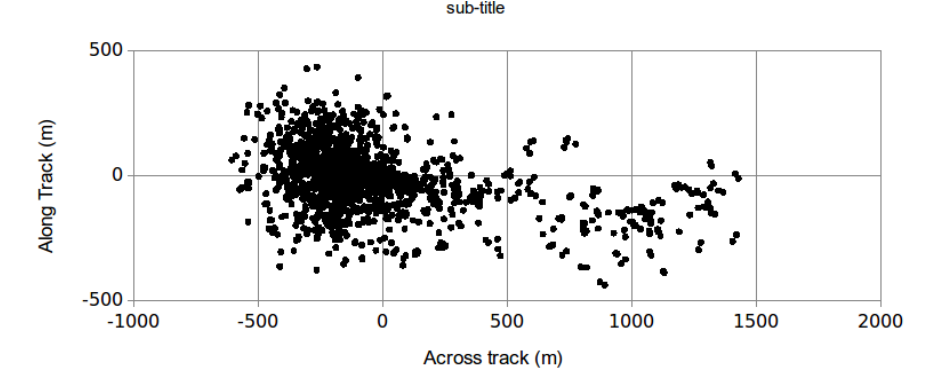
Figure 3. Geo-location errors before using ground control points, measured for all of the SPOT-4 (Take 5) scenes with enough cloud-free surface to perform a significant measurement. Although most of the measurements are below 500 m, several scenes with geo-location errors above 1000 m were